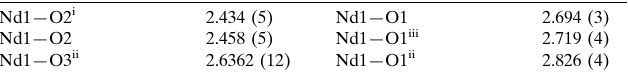
Selected bond lengths (A˚